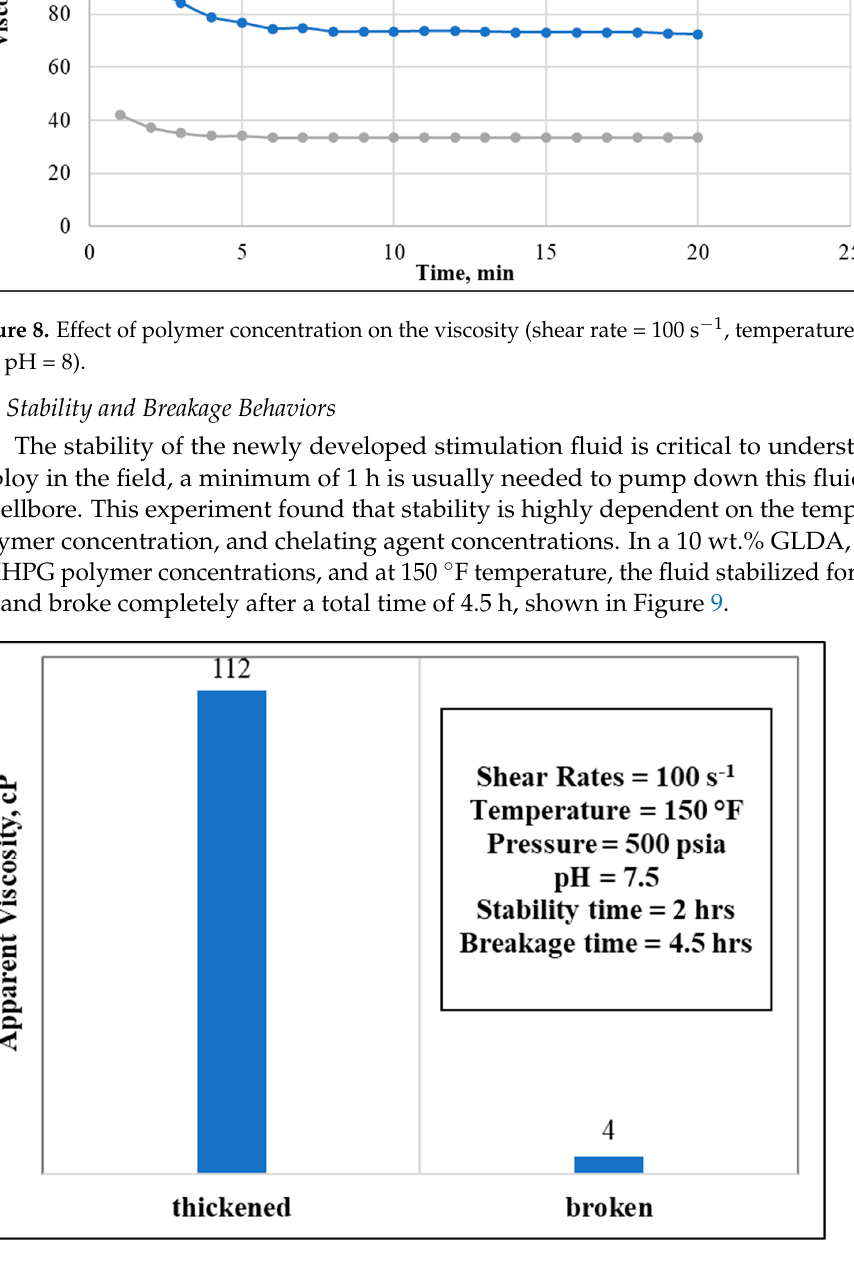
Figure 9. Thickening and breaking behaviors with respective parameters (polymer concentration= 50 pptg, GLDA concentration= 10 wt.%, water salinity = 70 k). In a 20 wt.% GLDA, 50 pptg CMHPG polymer concentrations, and at 150 ◦ F temper- ature, the fluid stabilized for around 2.4 h and broke completely after a total time of 6 h, reading higher viscosity values, as indicated in Figure